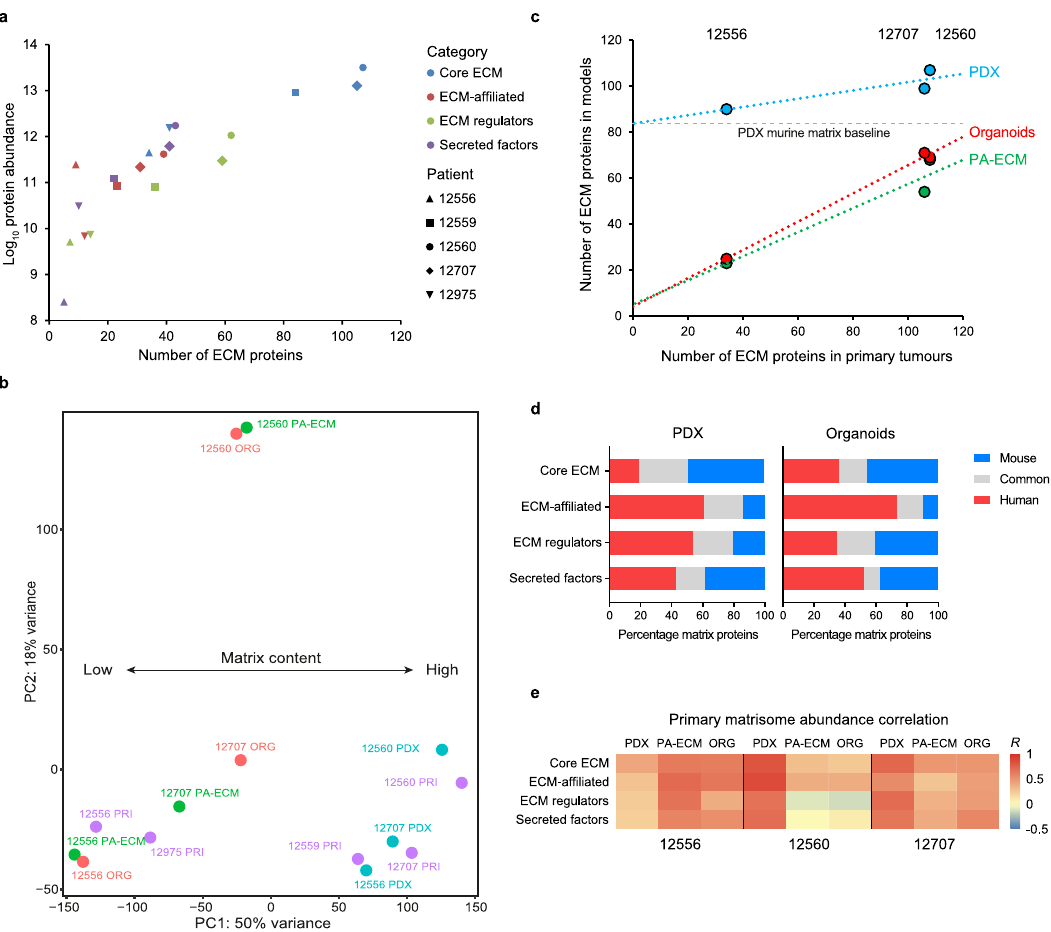
Fig. 7 In vivo and ex vivo PDAC matrisome analysis. a Scatter plot showing the total abundance and number of proteins of each matrisome category for each primary tumour analysed. b Principal component analysis of the core matrisome datasets from patients 12556, 12559, 12560, 12707 and 12975. c Scatter plot showing the correlation between the number of proteins of the primary core matrisomes and those of their corresponding PDX, PA-ECM and organoid models. The PDX murine baseline indicates the number of murine ECM proteins predicted to reside at the site of PDX implantation. d Percentage of matrisome peptides detected in the PDX and organoid samples which are of human, mouse or common origin. Common peptides are identical in both species. e Colour-coded correlation between the core matrisome protein abundances in primary tumours and their corresponding PDX, PA-ECM and organoid models. R is the correlation coef fi